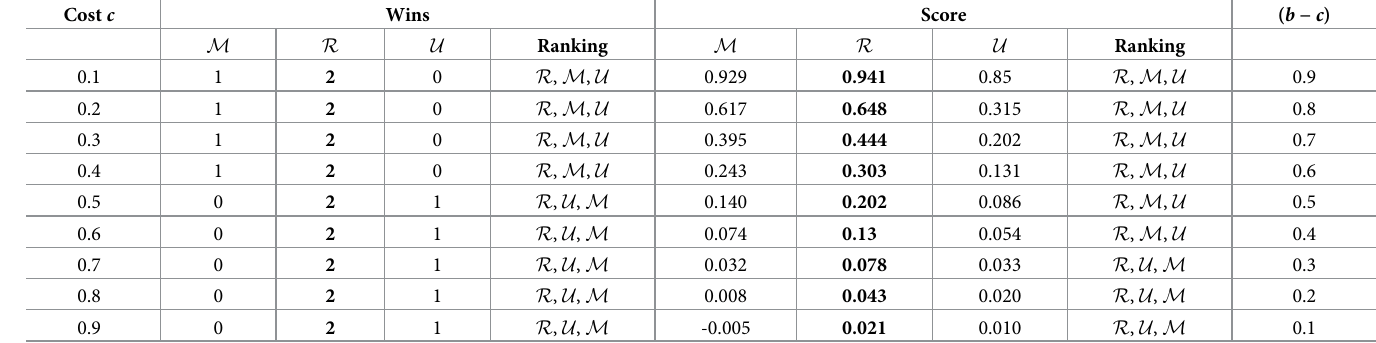
Table 2. Wins and scores in pairwise tournaments. To interpret the results of Table 1, we ( i ) count how often a memory space wins a pairwise competition, and ( ii ) we compute the memory space’s score by adding up its payoff against the two other memory spaces. With respect to both measures, we find again that reactive players outper- form players using the other two memory spaces. In general, however see that the rankings by wins and total score can differ. For example, for c = 0.5 and c = 0.6, U wins more often than M , but ranks last in terms of total score. Parameters are the same as in Table